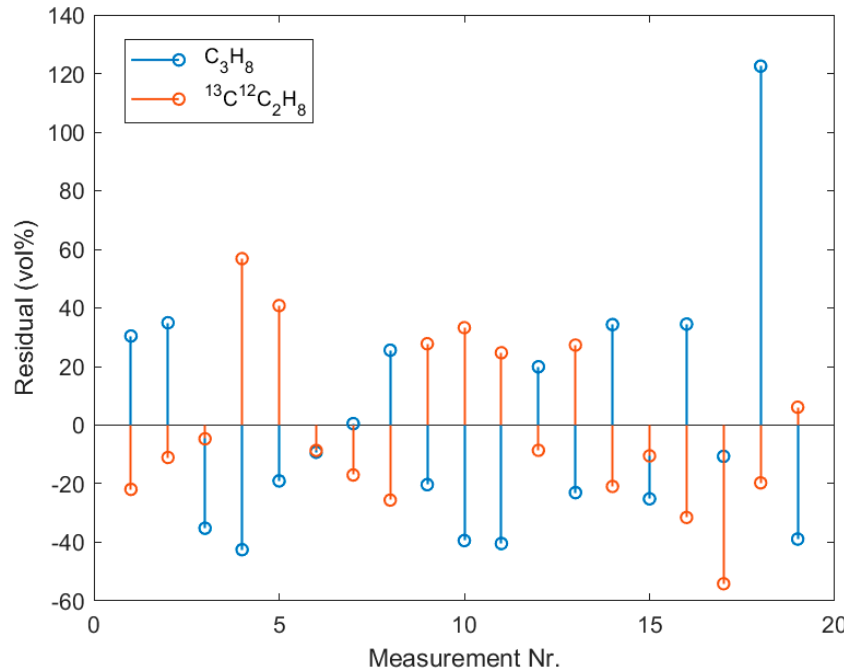
Figure A5. Cross validation residual of the ICL 1638 measurements.